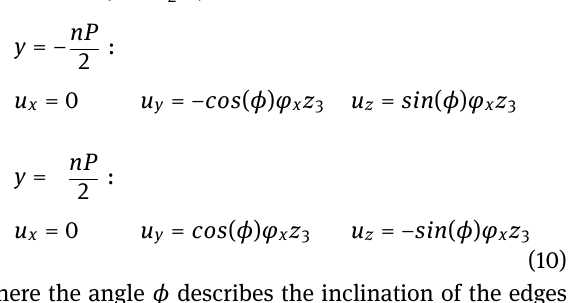
where the angle ϕ describes the inclination of the edges with respect to the z -axis and z nate mid-plane.